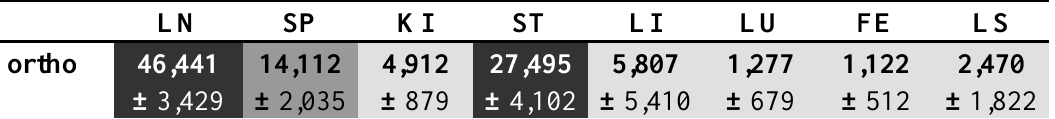
Table 1. Metastatic burden in different rat tissues of orthotopic MAT-Lu PCa determined by in vitro luciferase